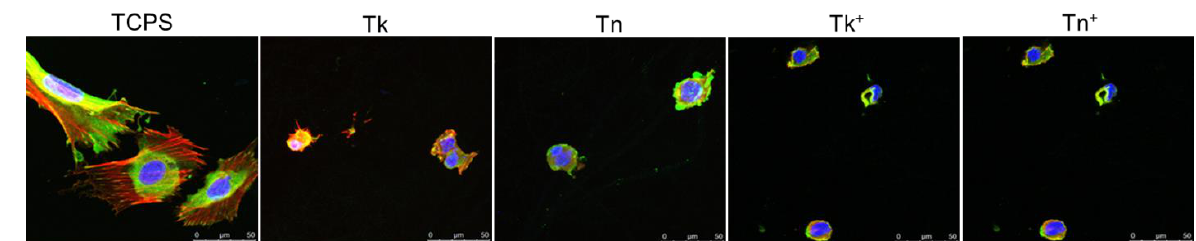
Figure 10. The cytoskeletal F-actin (red) distribution and vinculin focal adhesion protein (green) expression of fibroblasts after cultured on control (TCPS) and different CSNFMs for one day and examined under a confocal laser scanning microscope. The cell nuclei were counterstained with DAPI (blue). Bar = 50 μm.